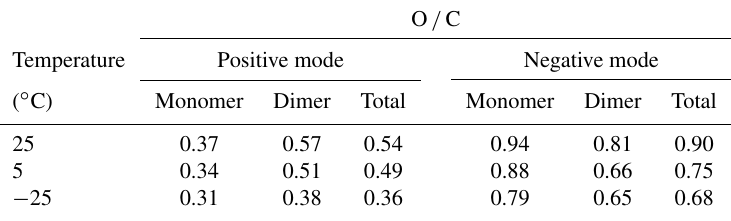
Table 2. Signal weighted average O:C ratios for positive and negative spectra at 25, 5 and − 25 ◦